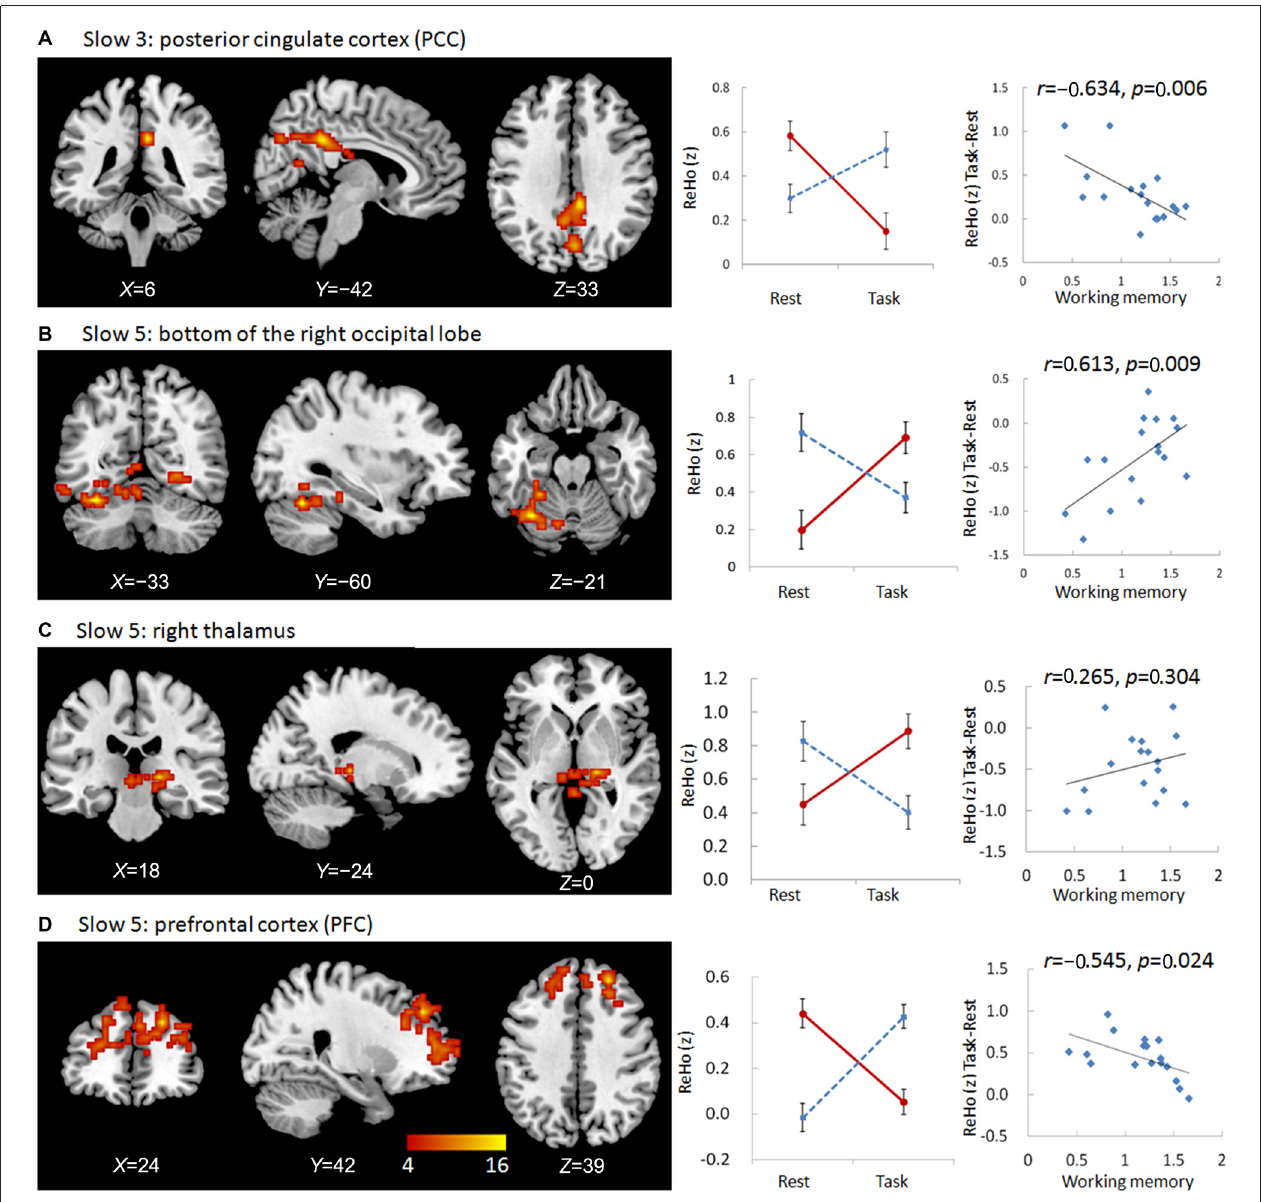
FIGURE 1 | Regions showing group × state interactions for ReHo including the posterior cingulate cortex (PCC) in slow-3 (A), and the bottom of the right occipital lobe (B), the right thalamus (C), and the prefrontal cortex (PFC; D) in slow-5. The color bar demonstrates F values. The corresponding graphs show the interaction patterns (middle panels) and correlation (right panels) between state-related change (task minus resting) of ReHo and working memory performance in mild cognitive impairment (MCI) patients.